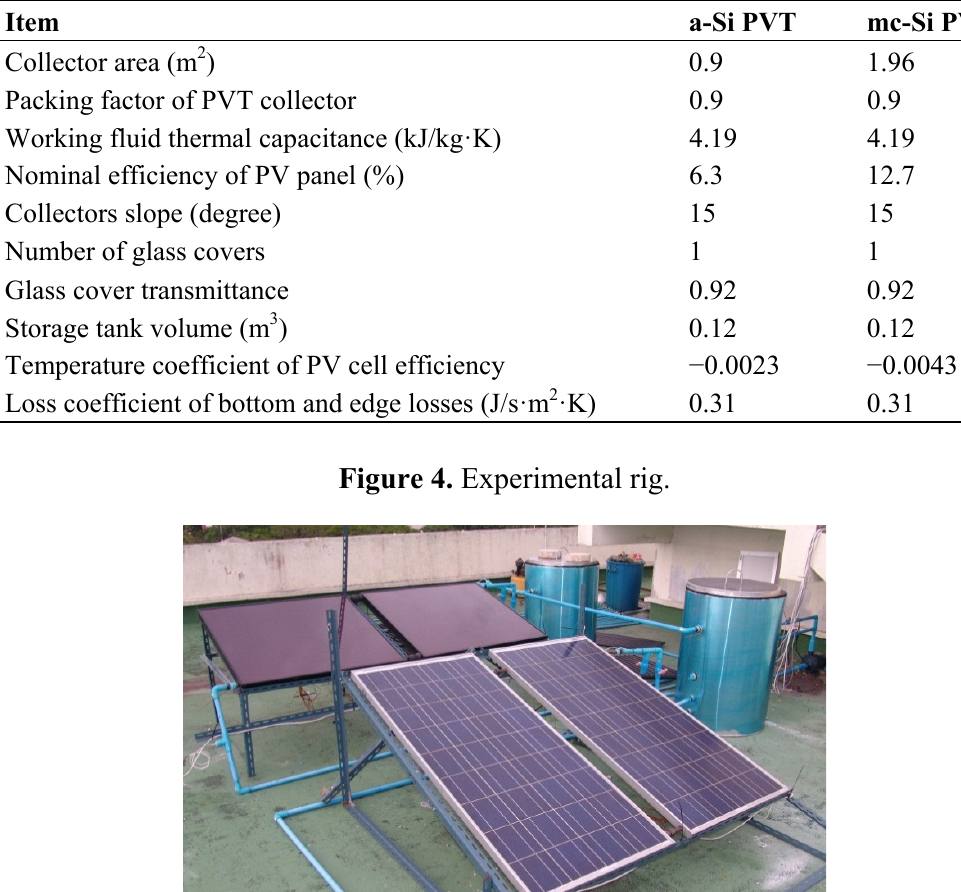
Table 1. System input